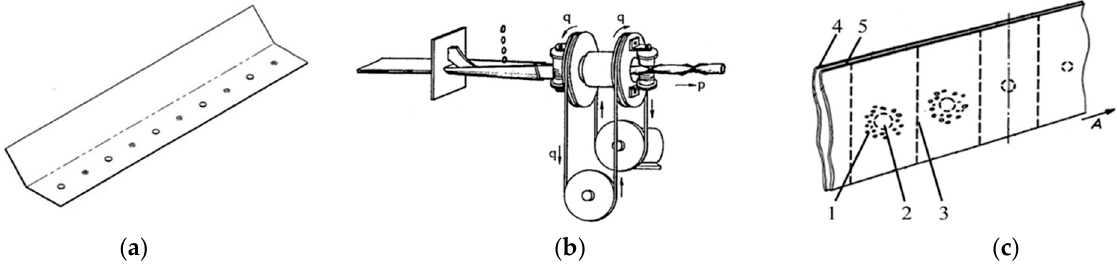
Figure 2. Three different types of seed tapes. ( a ) Folding type seed tape (https://patentimages.storage.googleapis.com/3d/48/6b/a92c63f9077c3f/US20110271888A1.pdf (accessed on 21 November 2021)) [46] ( b ) Device for making water-soluble seed tapes [47]; ( c ) Seed tape designed by Ahm (https://patentimages.storage.googleapis.com/6c/5b/13/f2be258f5ff65f/WO2007065436A1.pdf (accessed on 21 November 2021)) [48]. 1. Binder 2. Seed 3. Dividing line 4. Rear containment material 5. Front containment material.